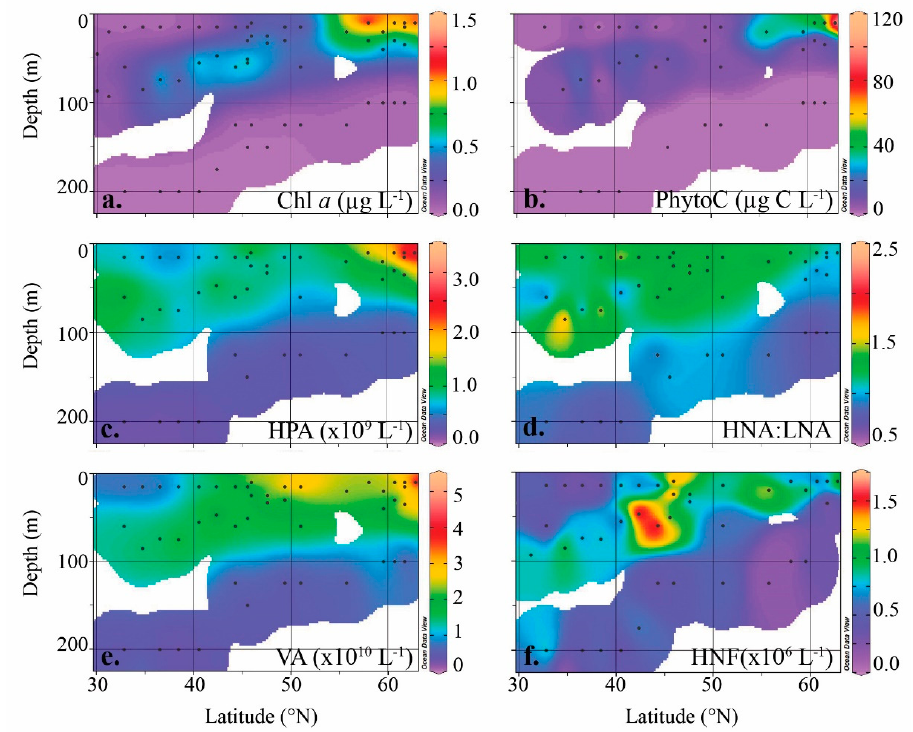
Figure 2. Biogeographical distributions of ( a ) Chl a , ( b ) phytoplankton carbon (PhytoC), ( c ) heterotrophic prokaryote abundance (HPA), ( d ) high nucleic acid fluorescent (HNA):low nucleic acid fluorescent (LNA), ( e ) virus abundance (VA), and ( f ) heterotrophic nanoflagellate abundance (HNF) across the Northeast Atlantic Ocean obtained during the STRATIPHYT cruise. Black dots indicate sampling points. Graphs were prepared with Ocean Data View version 5.2.